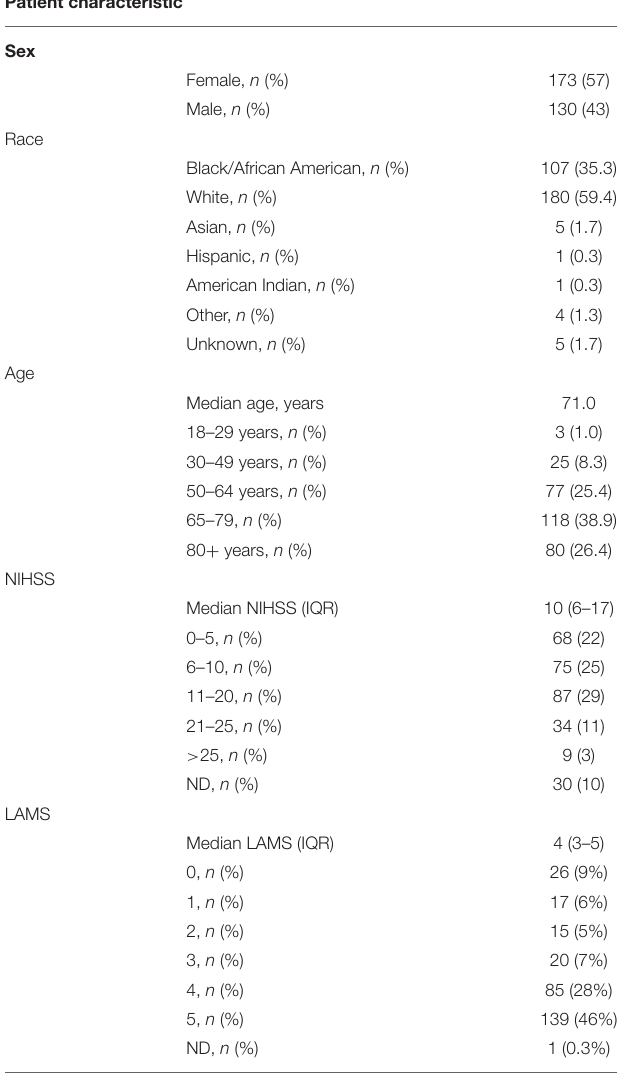
TABLE 2 | Baseline demographics of rerouted patients.